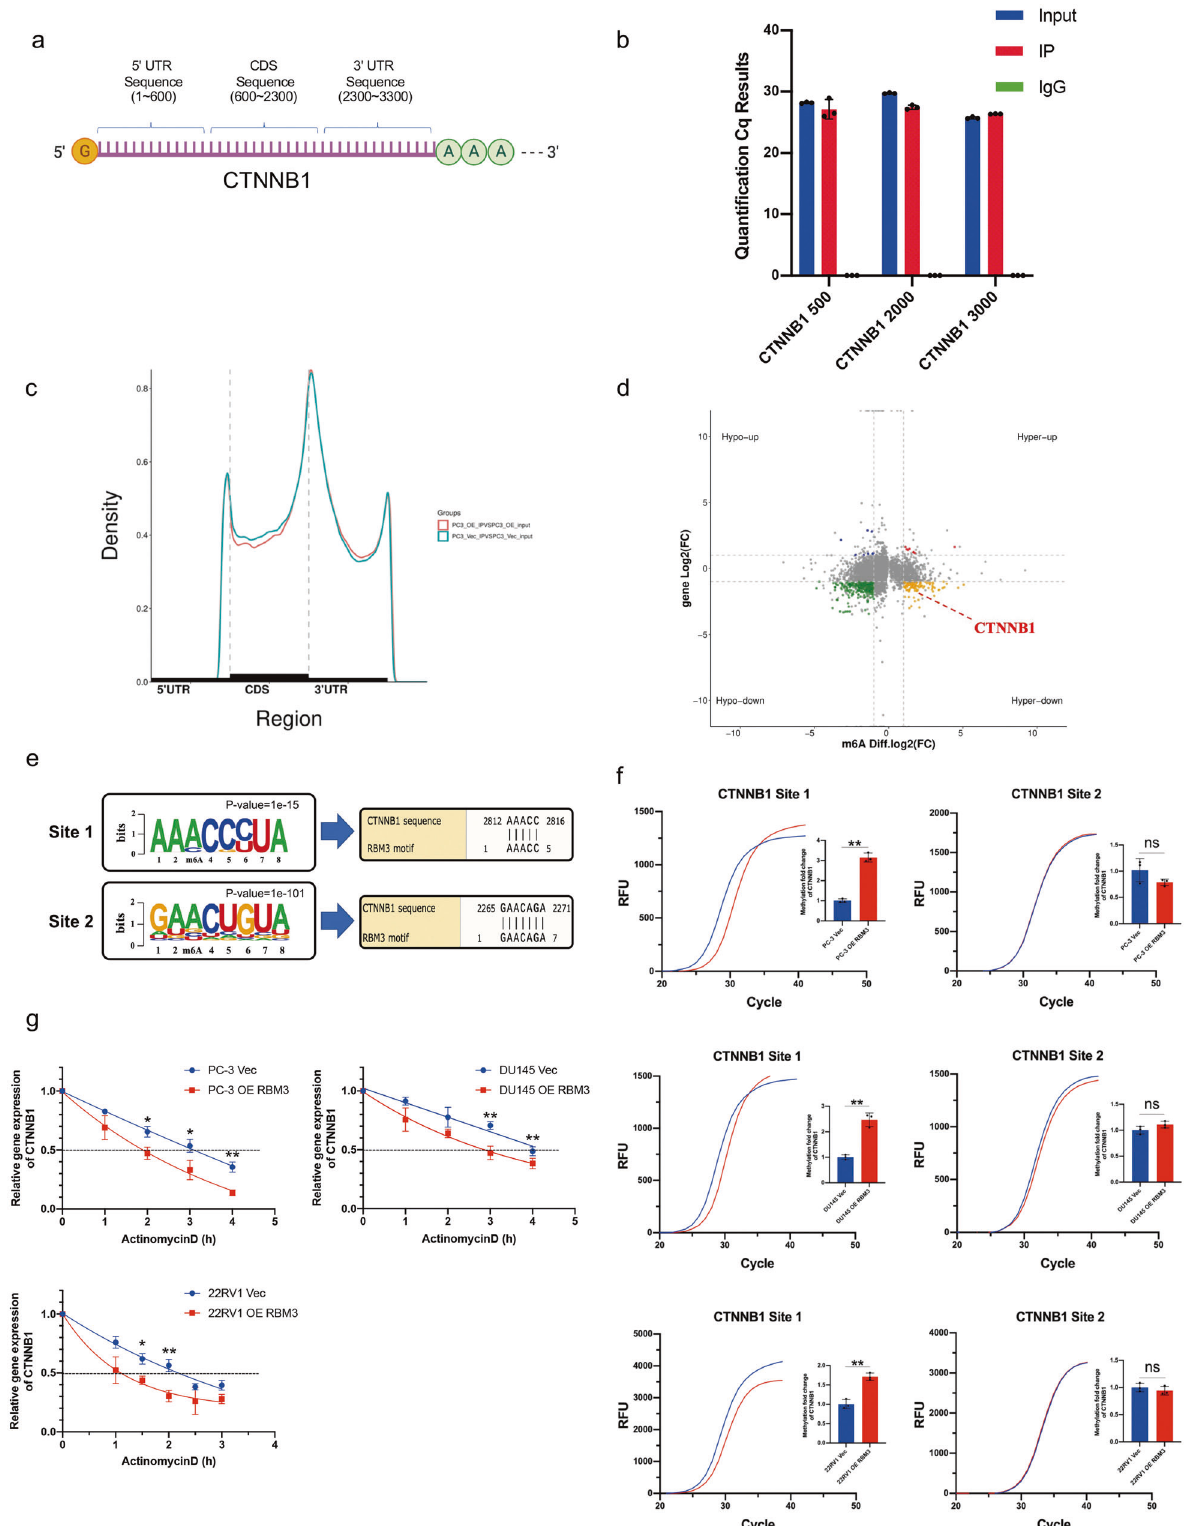
fl uorescence signal detected in the right hindlimb of the mice, where PC-3 cells without RBM3 overexpression were injected, but no fl uorescence signal was detected in the left hindlimb, where PC-3 cells with RBM3 overexpression were injected (Fig. 6b).